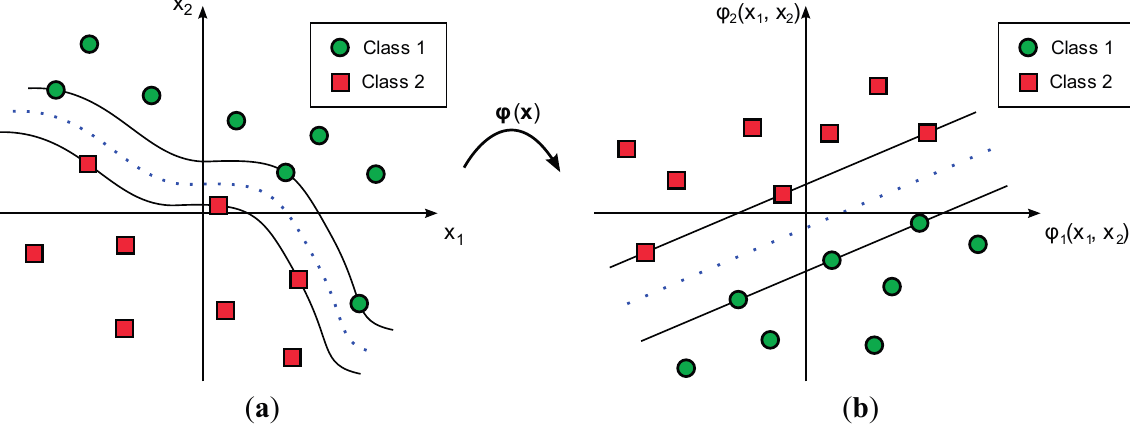
Figure 2. Representation of a Support Vector Machine classifier with a nonlinear kernel. Function (cid:2256)(·) is the nonlinear transformation mapping vectors from ( a ) the input space to ( b ) the feature